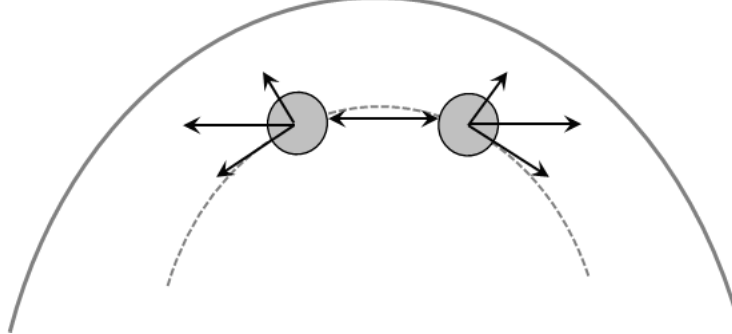
Figure 11. Schematic diagram illustrating the interactions between two particles in a curved geometry (based on [32]).